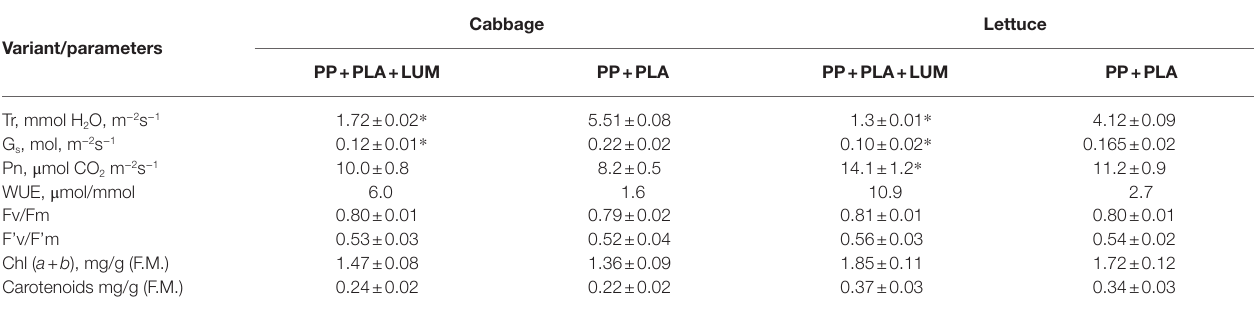
TABLE 2 | The stomatal conductance, transpiration rate (Tr), photosynthesis rate, and water use efficiency (WUE) of 32-day-old cabbage and lettuce plants grown under the covering with the addition of photoluminophore (+LUM) and without the additive (–LUM). Cabbage Variant/parameters